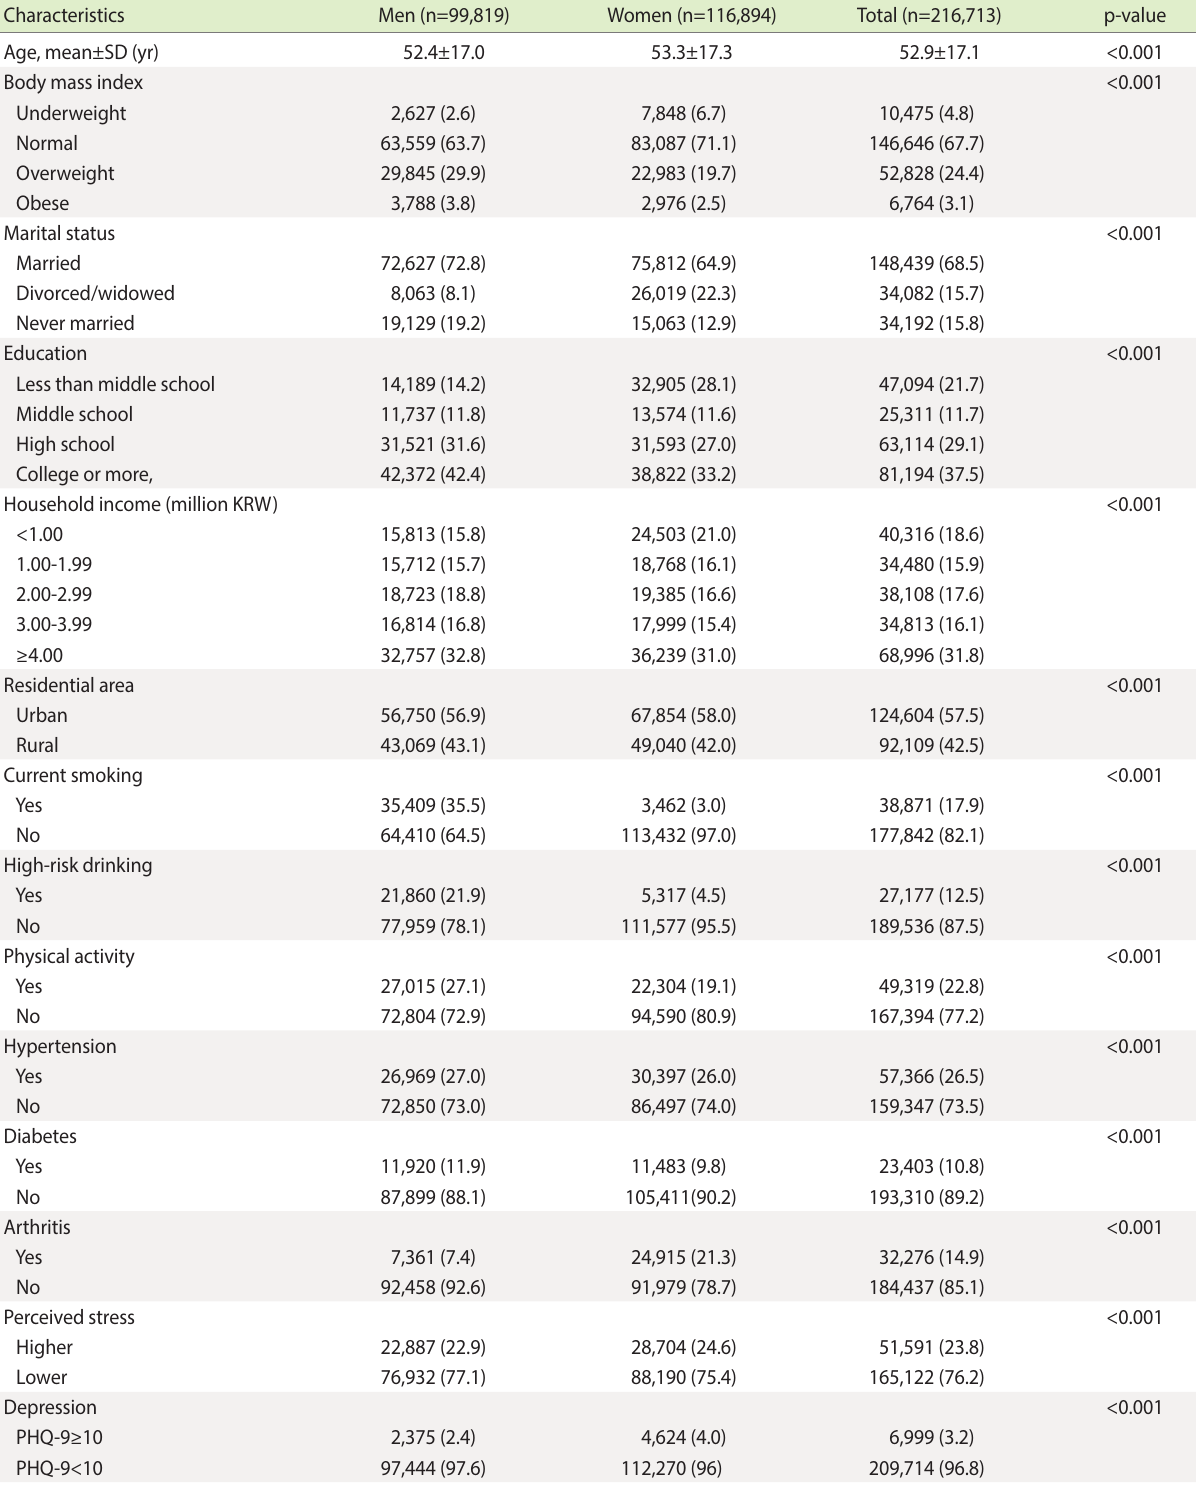
Table 1. General characteristics of the study subjects